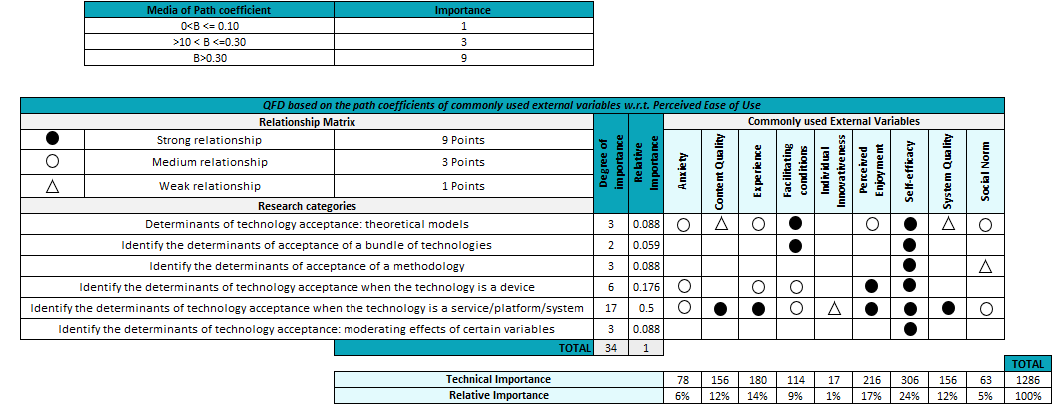
Figure 7. QFD matrix for Perceived Ease of